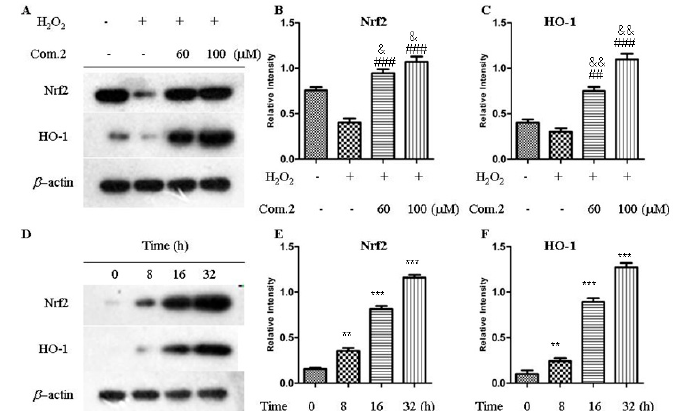
Figure 6. Effects of compound 2 on the expression of Nrf2 and HO-1 in MIN6 cells. ( A ) Expression levels of Nrf2-mediated antioxidant proteins were detected by Western blot analysis in 16 h. ( B , C ) Quantification of Nrf2 and HO-1 protein expression. Data are presented as means ± SDs of three independent experiments. & p < 0.05, && p < 0.01 compared with control group (untreated with H 2 O 2 and compound 2 ). ## p < 0.01, ### p < 0.001 compared with model group (only treated with H 2 O 2 ). ( D ) Expression levels of Nrf2-mediated antioxidant proteins after the cells were incubated with 100 μ M of compound 2 for the indicated time period. ( E , F ) Quantification of Nrf2 and HO-1 protein expression. Data are presented as means ± SDs of three independent experiments. ** p < 0.01, *** p < 0.001 compared with control